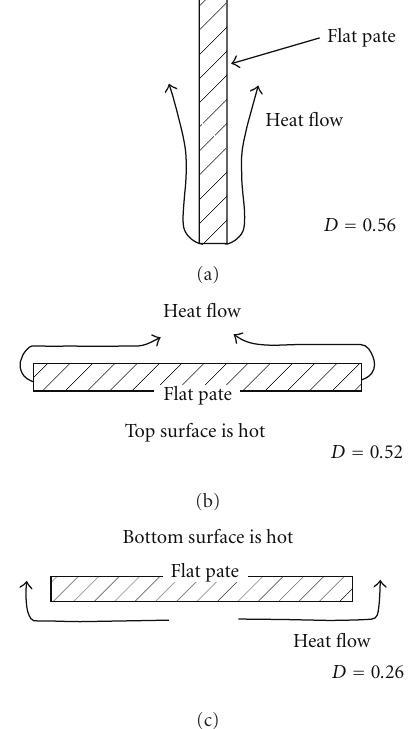
Figure 7: Value D in natural heat transfer equation (5).